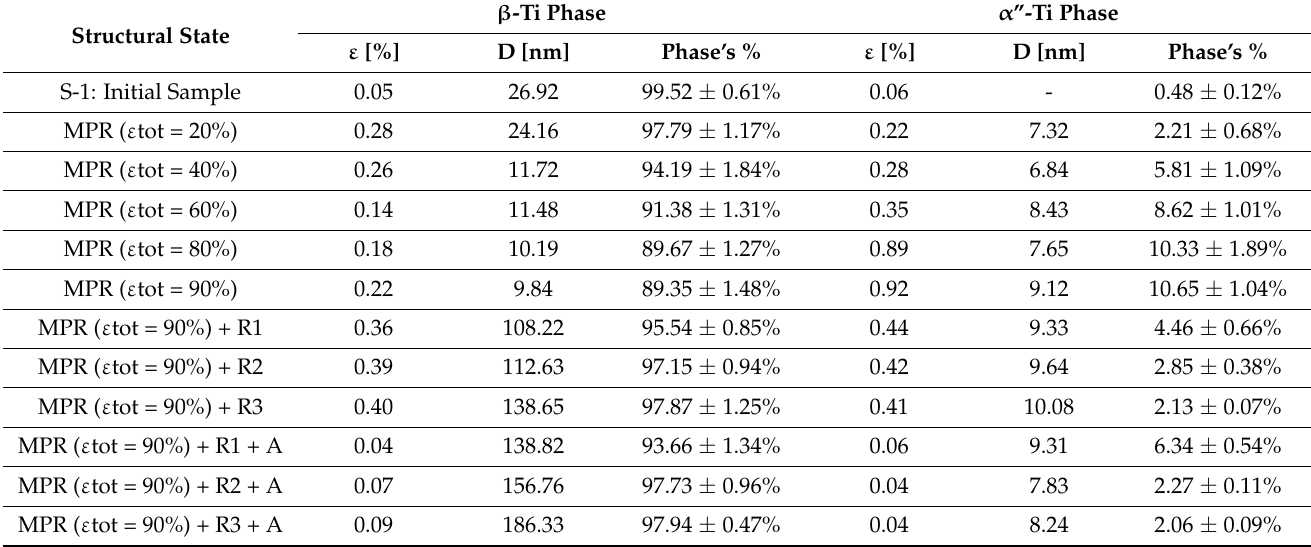
Table 2. The average dimensions of the coherent crystallite (D, nm) and micro-deformations ( ε , %) corresponding to β -Ti and α (cid:48)(cid:48) -Ti phases identified for all analyzed stages of the studied alloy (MPR—multi-pass rolled sample; R—recrystallized